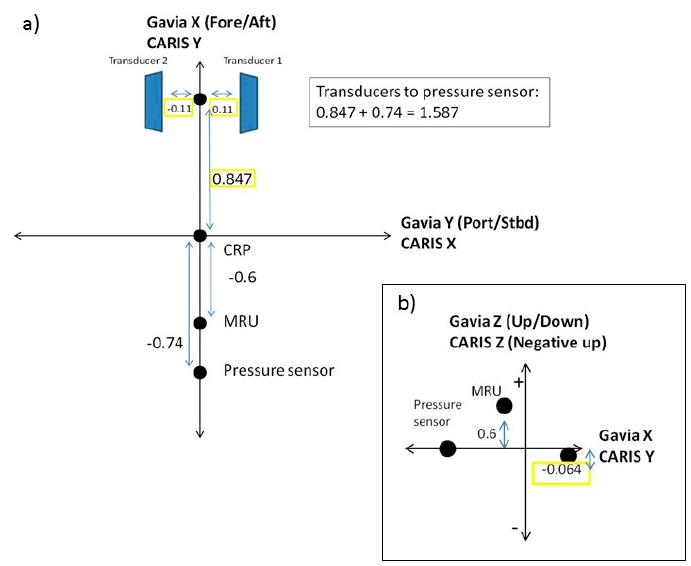
Figure 4. This figure shows the offsets determined from the CARIS and Gavia orientation conventions. The values highlighted in yellow were values provided in the original vessel file. All other values were taken from the Gavia Operations Manual [32]; ( a ) shows the orientation of the vehicle in top down dimension and ( b ) shows the vehicle in cross-section. All units are in meters.